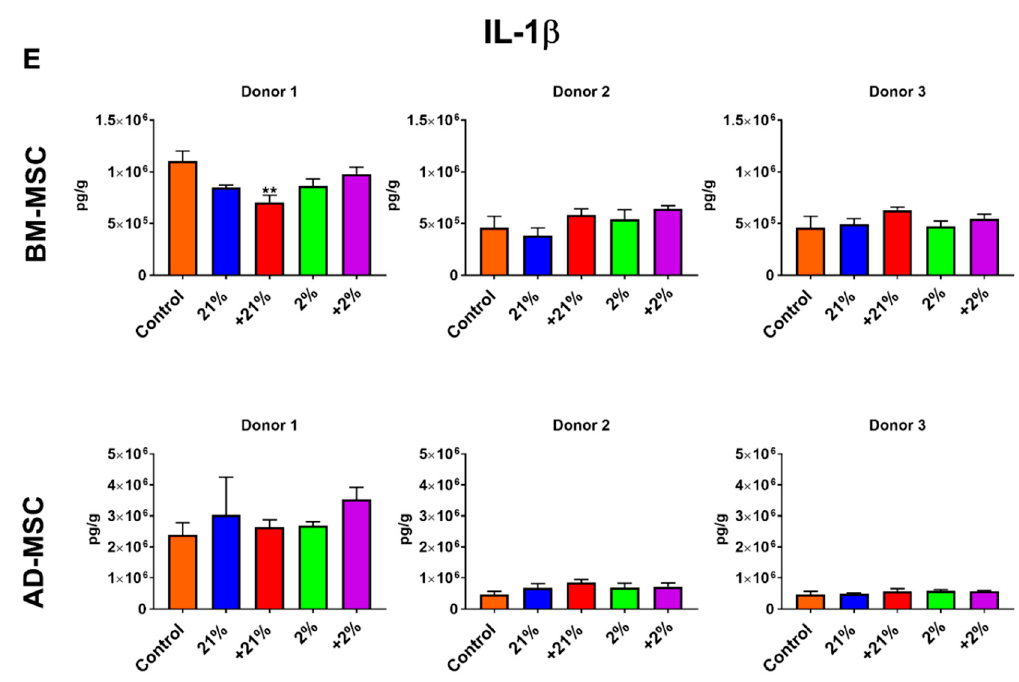
Figure 5. An inflammatory response to a lipopolysaccharide (LPS) challenge in a co-culture system of MSCs and MNCs. Preconditioning significantly augmented the anti-inflammatory response of BM-MSCs and AD-MSCs by increasing IL-10 ( A ) and IL-1RA ( B ) levels while significantly suppressing the secretion of TNF- α ( C ). Cytomix treatment elicited the most potent response with significantly increased production of IFN- γ ( D ), whereas no significant differences were observed in levels of IL-1 β ( E ). * p < 0.05, ** p < 0.01, *** p < 0.001, **** p < 0.0001.